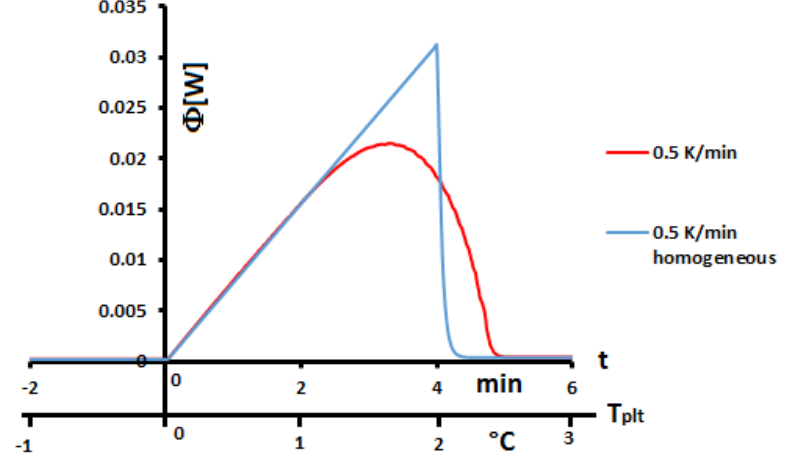
Figure 1. DSC curves at the smallest experimental heating rate β = 0.5 K/min with standard and homogeneous models for a pure substance.